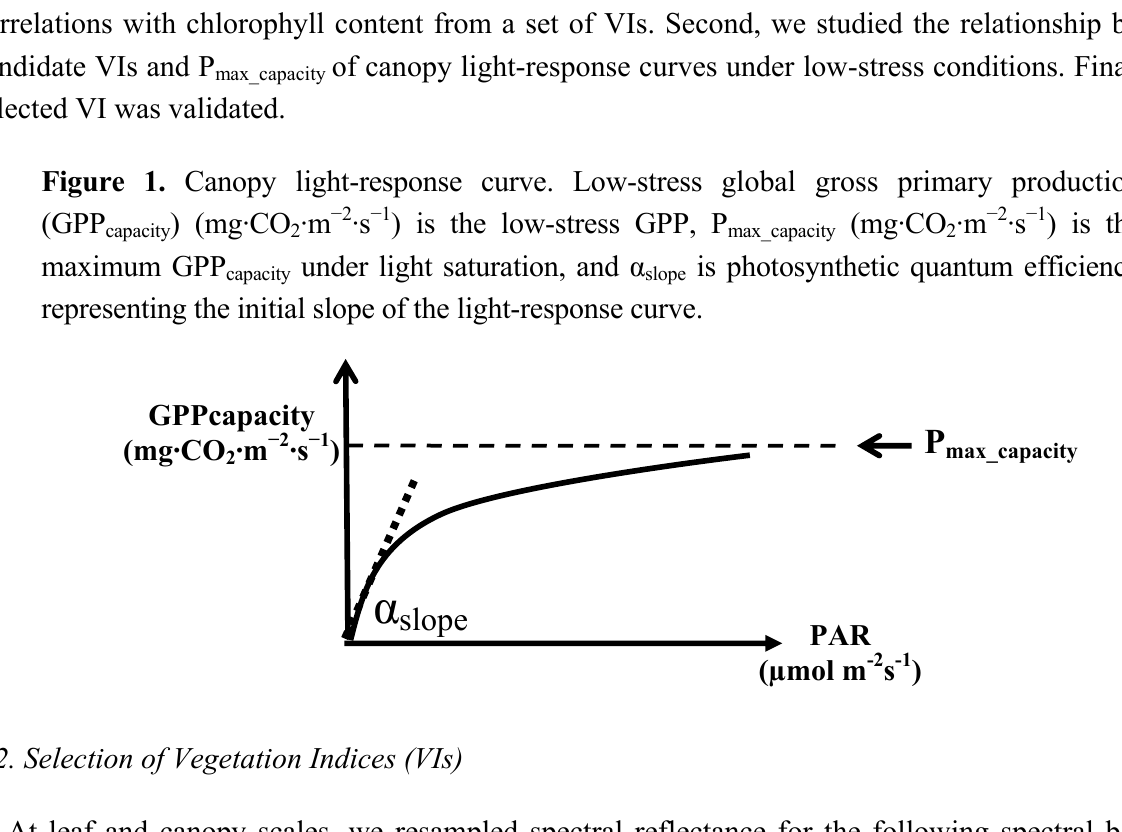
(mg·CO ·m − 2 ·s − 1 ) is the max_capacity 2 is photosynthetic quantum efficiency slope